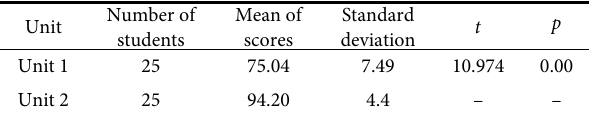
Table 4 Students ’ assessment score across two